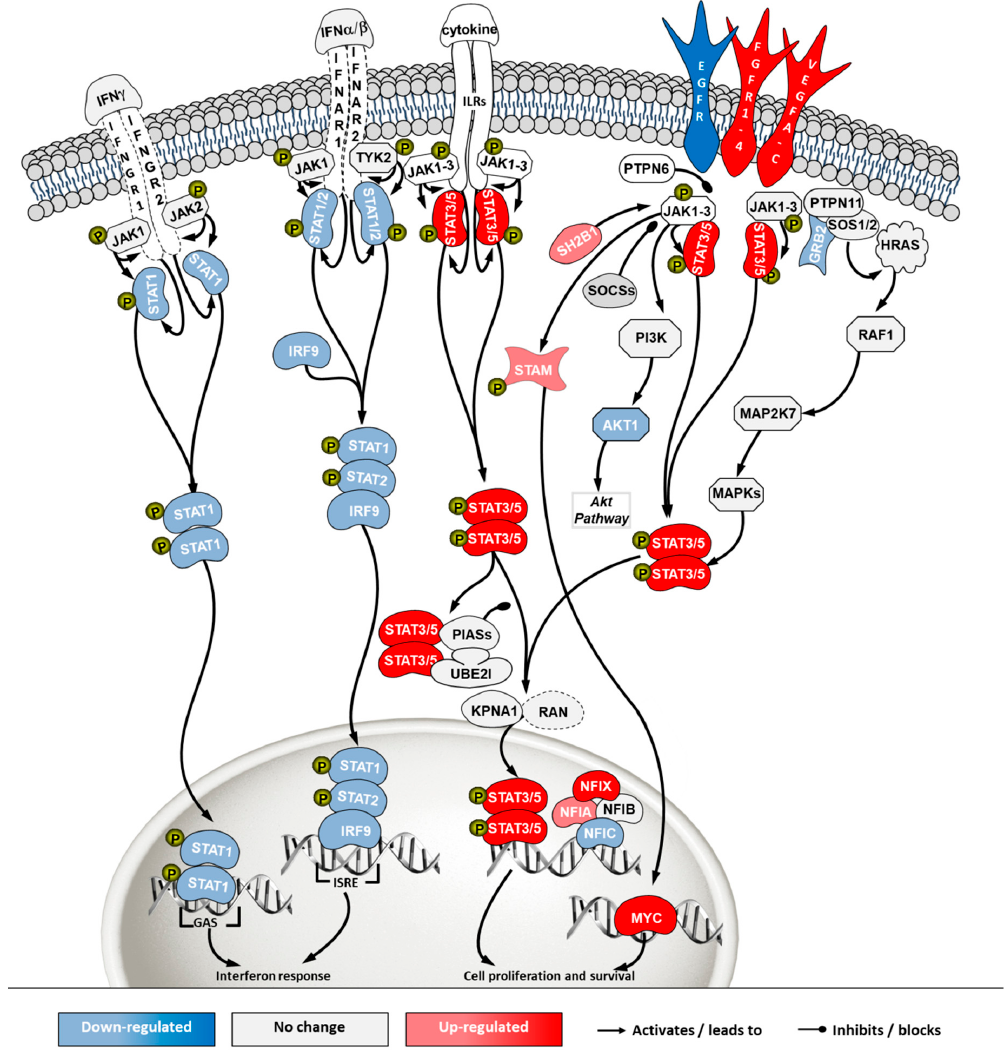
Figure 8. Differential gene expression in Janus kinase/signal transducers and activators of transcription (JAK/STAT) pathway in ‘ECACC vs. ATCC’ cells. For further details refer to the caption of Figure 7.